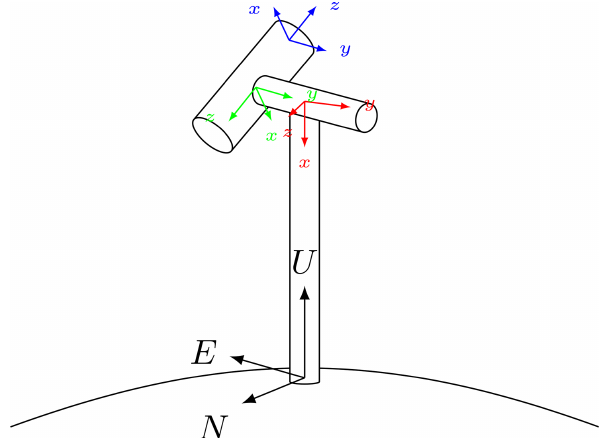
Figure 9. Sketch of the SSARA instrument and the coordinate sys- tems used for the mount calibration; ENU (black), MNT (red), GMB (green), and SH (blue).